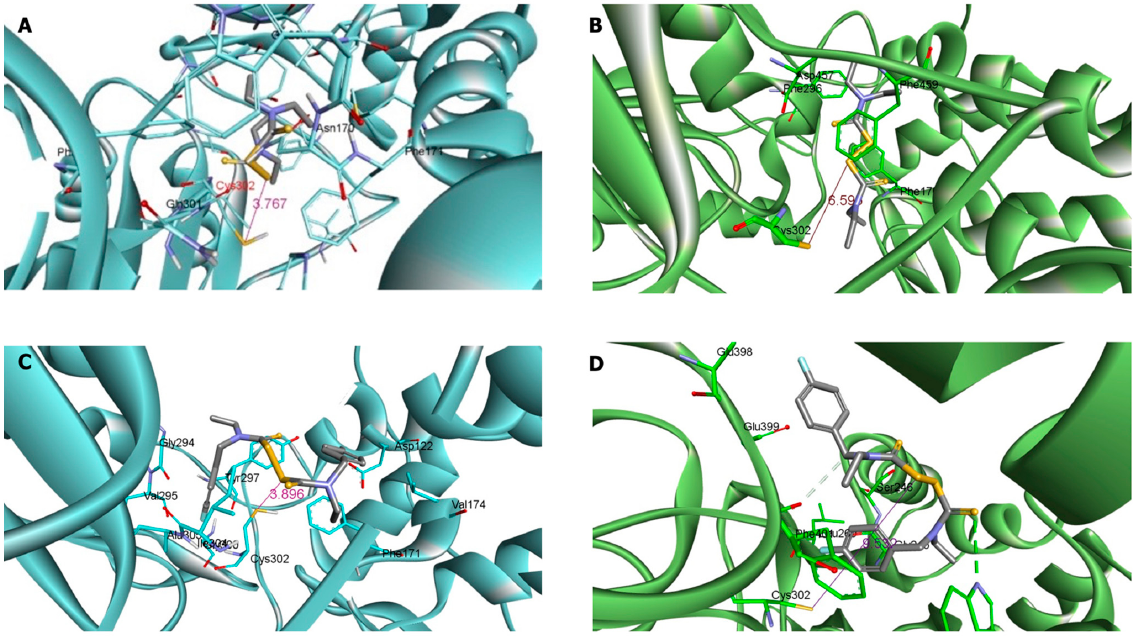
Figure 4. ( A ). Molecular docking of disulfiram into ALDH1a1. ( B ). Molecular docking of disulfiram into ALDH2. ( C ). Molecular docking of ( 2 ) into ALDH1a1. ( D ). Molecular docking of ( 2 ) into ALDH2.